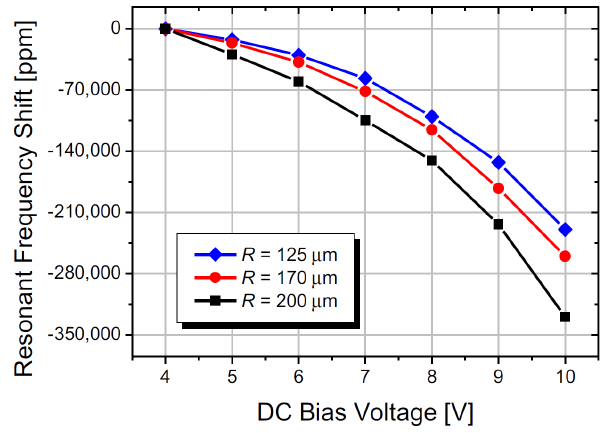
Figure 19. Measured resonant frequency shift of ring resonators in response to the change in DC voltage applied to Pt electrodes [64]. Reprinted from Sens. Act. A: Phys., 226, Sviliˇci´c et al., Widely tunable MEMS ring resonator with electrothermal actuation and piezoelectric sensing for filtering applications, 149–153, c (cid:13) 2015, with permission from